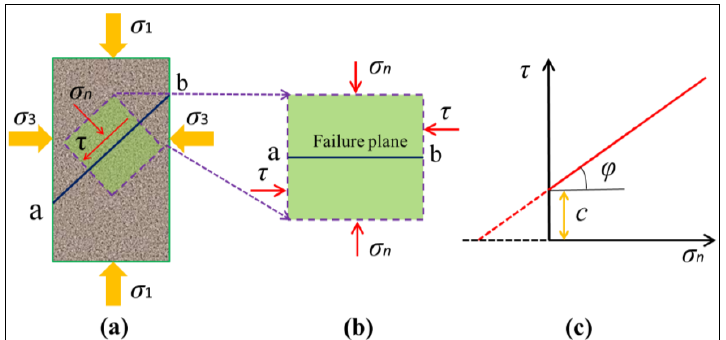
Figure 4. Mohr-Coulomb strength criterion. ( a ) Shear failure on plane a–b under triaxial stress state and σ 3 is the confined pressure; ( b ) Shear failure under direct shear test; ( c ) Relationship between shear stress and normal stress.